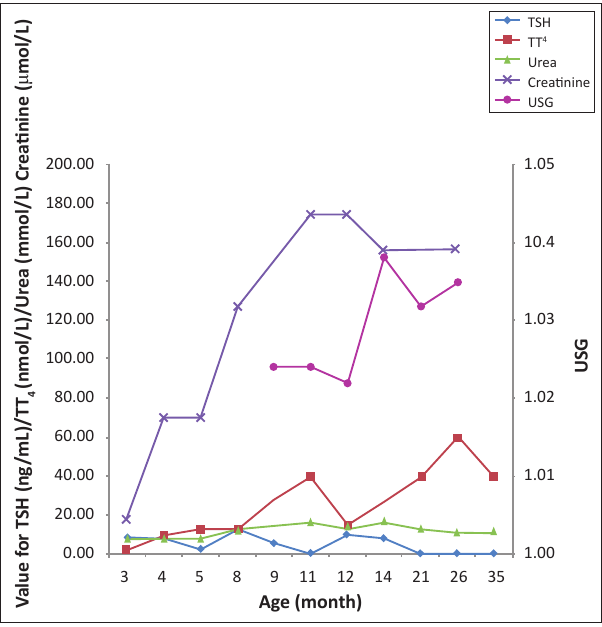
FIGURE 4: Graphic representation of the serum thyroid stimulating hormone, total thyroxine, urea and creatinine concentrations, and urine specific gravity in a cat diagnosed with primary congenital hypothyroidism and renal insufficiency.